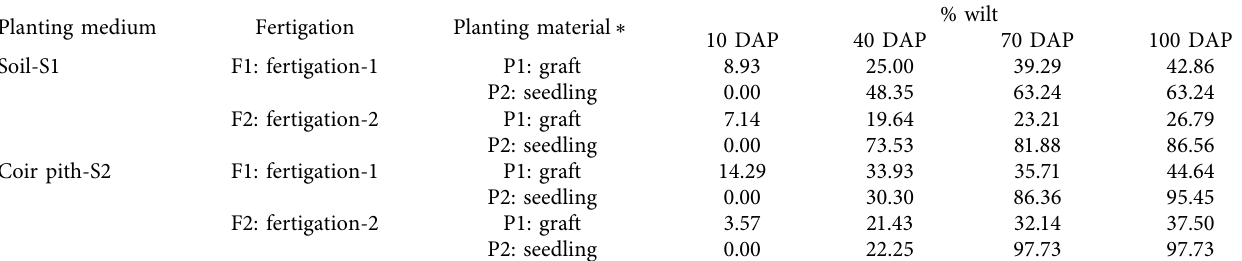
Table 4: Incidence of bacterial wilt in tomato (GS-600) grafts and nongrafted seedlings planted with two fertigation levels on two planting media in polyhouse